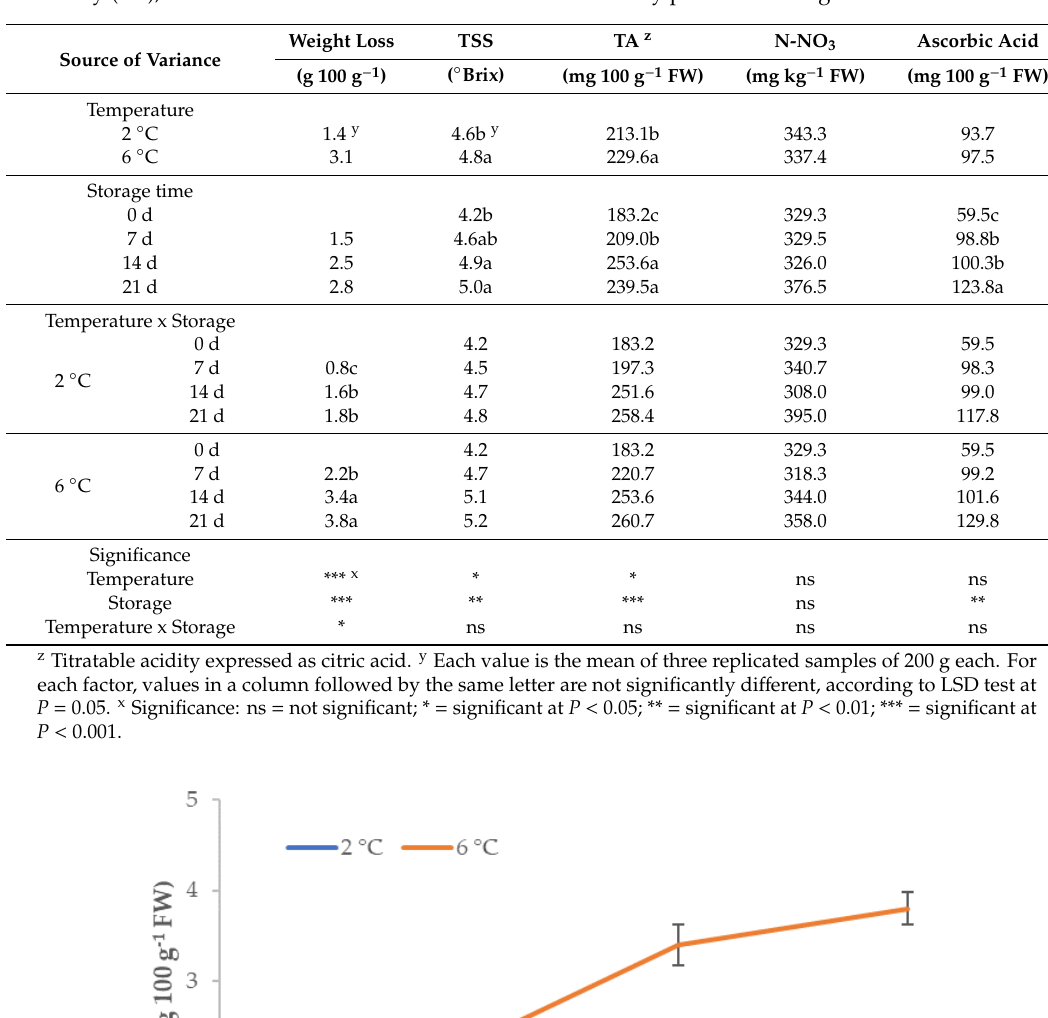
Table 1. E ff ect of temperature and time of storage on weight loss, total soluble solids (TSS), titratable acidity (TA), and ascorbic acid and nitrate content of minimally processed borage leaves.